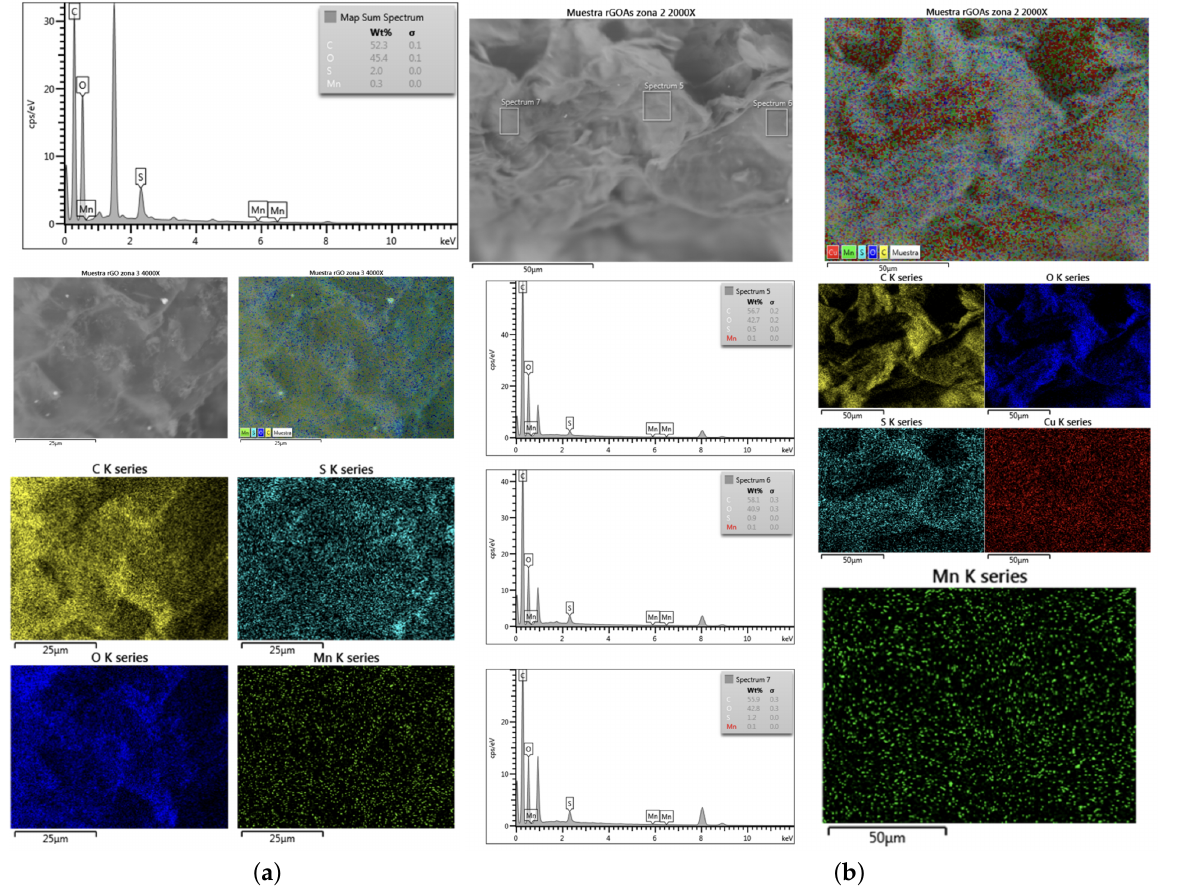
Figure 8. EDS analysis of the ( a ) MnO 2 /rGO (one zone) and ( b ) MnO 2 AsA/rGO (three zones) nanocomposites.